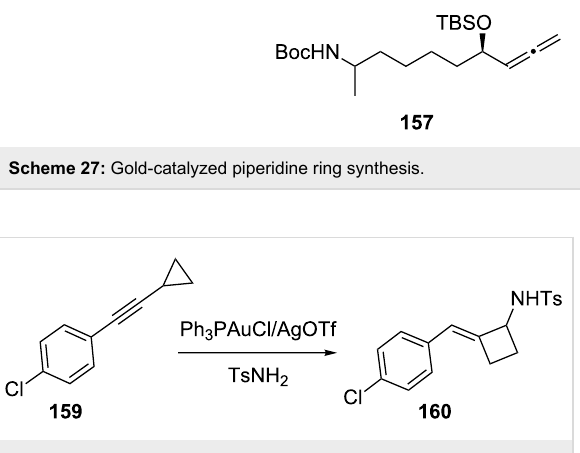
Scheme 28: Ring expansion of alkylnyl